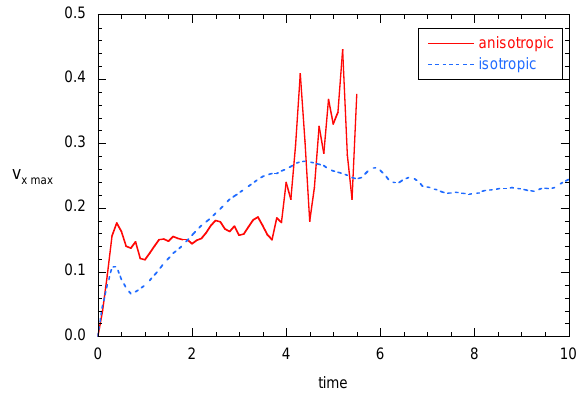
Fig. 16. Maximum earthward flow speed as a function of time for a bubble with y m = 0 . 2 governed by a double-adiabatic anisotropic model (solid line), compared to the isotropic model (dotted